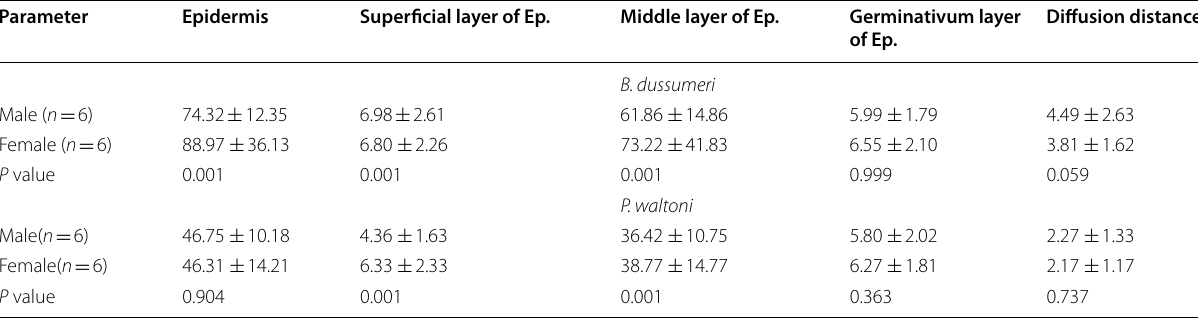
Table 1 The mean ( SD) thickness (μm) of the skin structural components in male and female B. dussumeri and P. waltoni ±